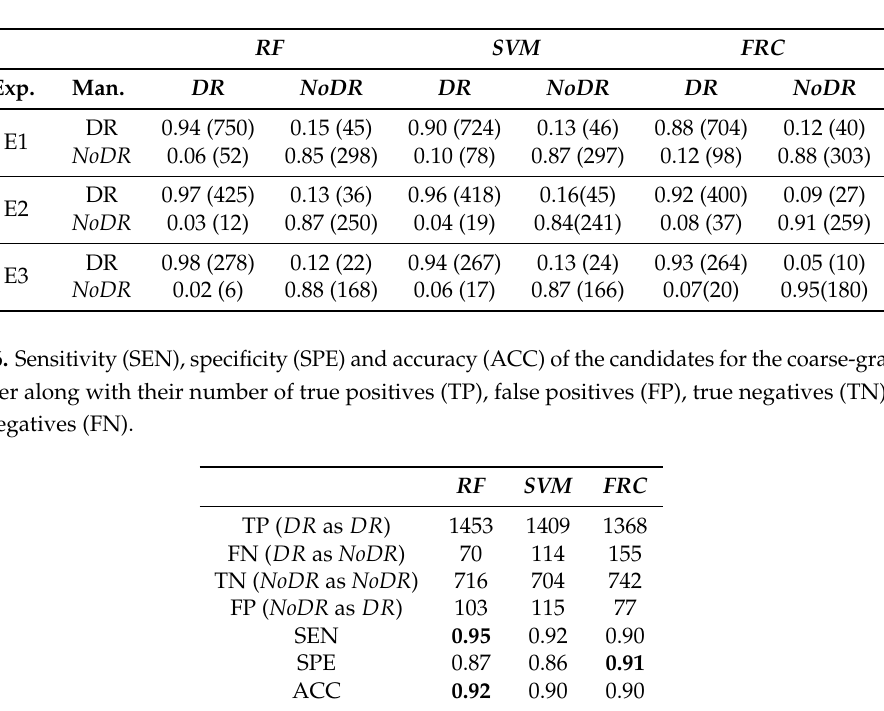
Table 5. Confusion matrix of the candidates when acting as a coarse-grained classifier in terms of percentage and number (in brackets) of correctly-classified instances.